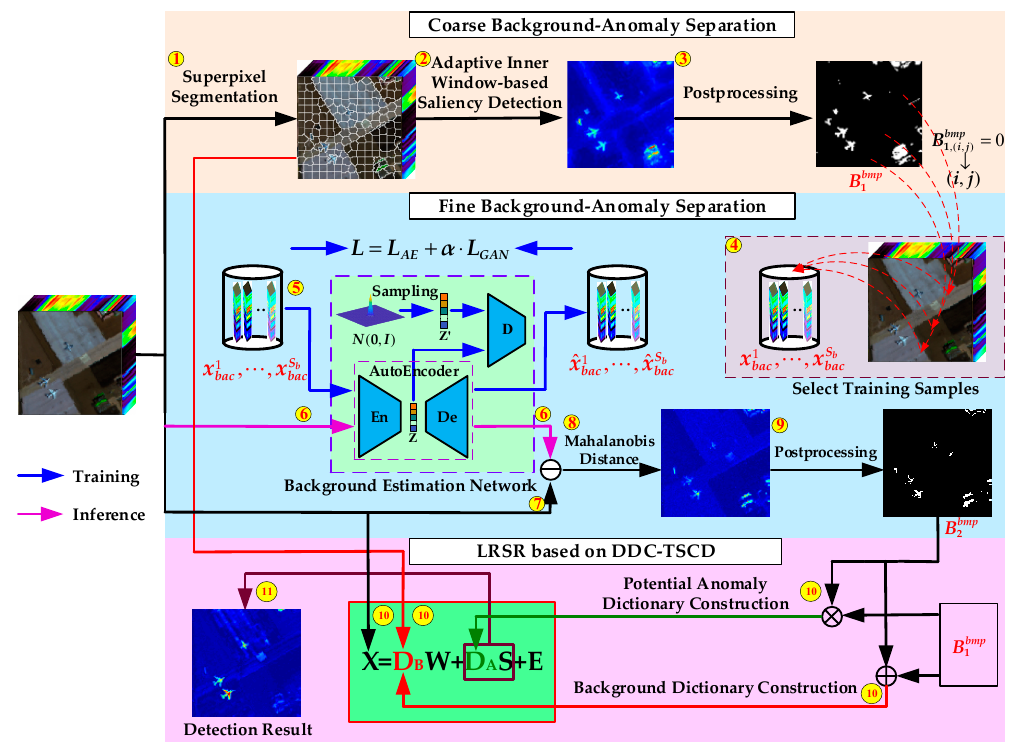
Figure 1. Visualization of chosen atoms in background and potential anomaly dictionaries for PAB- DC and the proposed method on the Los Angeles dataset. Here, green dots indicate chosen atoms in background and potential anomaly dictionaries, and the red areas represent the corresponding anomalies in the reference map. Note: ( I , II ) stand for the PAB-DC and the proposed method, re- spectively; ( a , b ) separately refer to the background dictionary and potential anomaly dictionary.